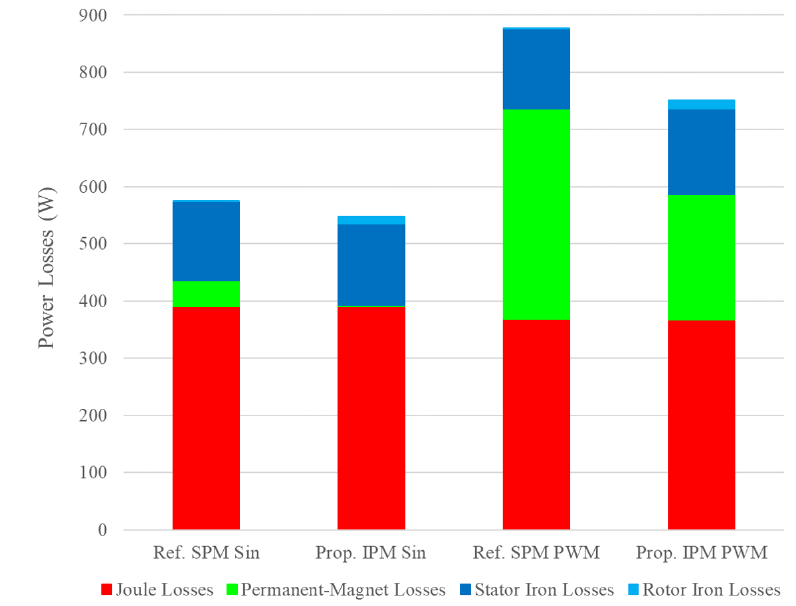
Figure 10. Comparison of power losses composition at 3000